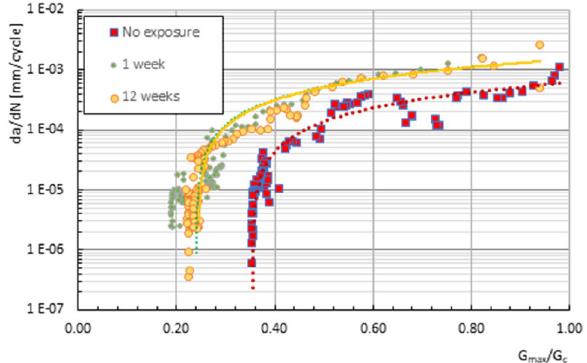
Figure 7. Fatigue crack growth rate versus normalised maximum ERR for the different exposure periods studied.